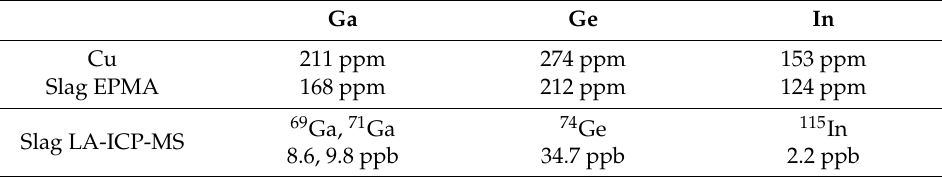
Table 1. Detection limits of Ga, Ge and In by EPMA and LA-ICP-MS.